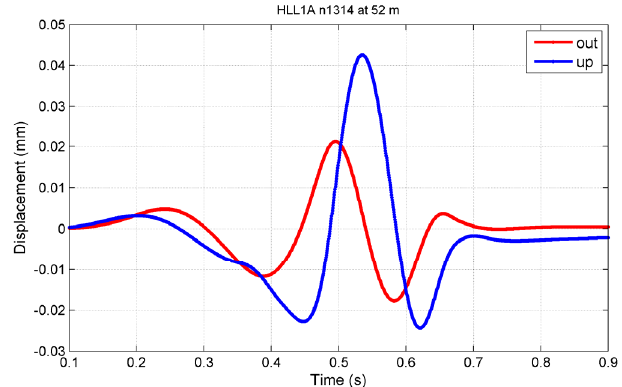
Figure 6. A time series of upward and outward motions at node 1314.